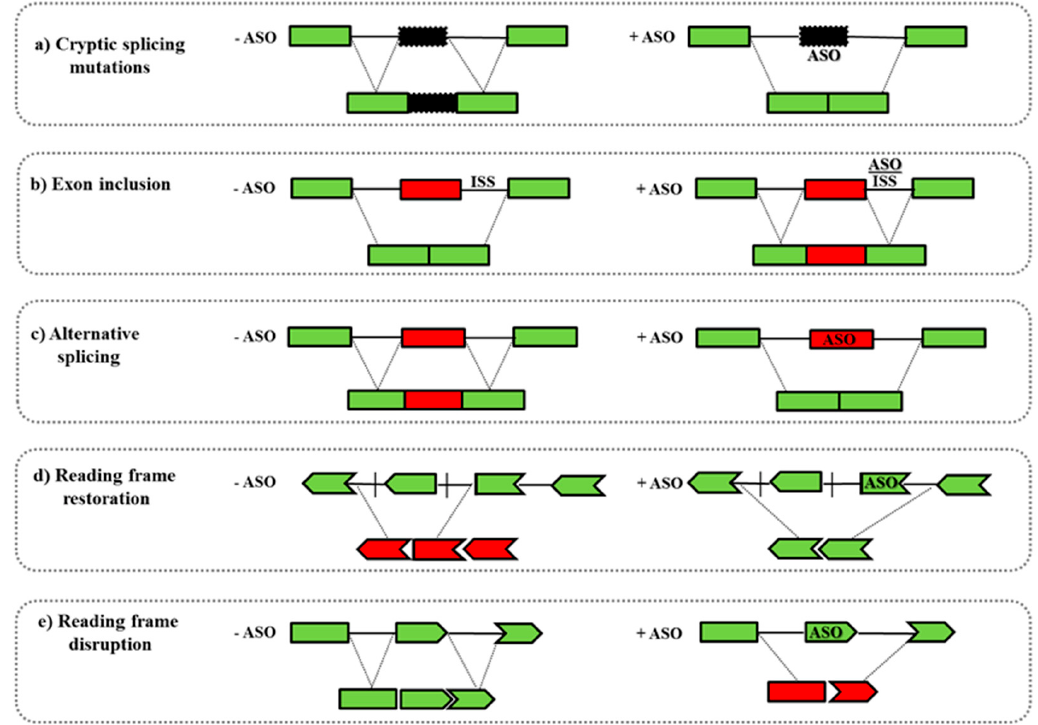
Figure 2. Antisense-mediated exon skipping mechanisms. ( a ) Cryptic splicing mutations induce the inclusion of an aberrant exon (black box) into the mature transcript and the ASO can skip the cryptic exon restoring the normal transcript; ( b ) exon inclusion can be induced by ASO that, targeting the intronic splicing silencers (ISS) generated by the mutation, restores the correct exon inclusion (red box); ( c ) ASO can be used for switching between alternative splicing isoforms; ( d ) ASO can support exon skipping restoring the correct reading frame; ( e ) ASO can induce the translation of an internally deleted protein or can generate reading frame disruptions with consequent partially or complete transcript knockdown.